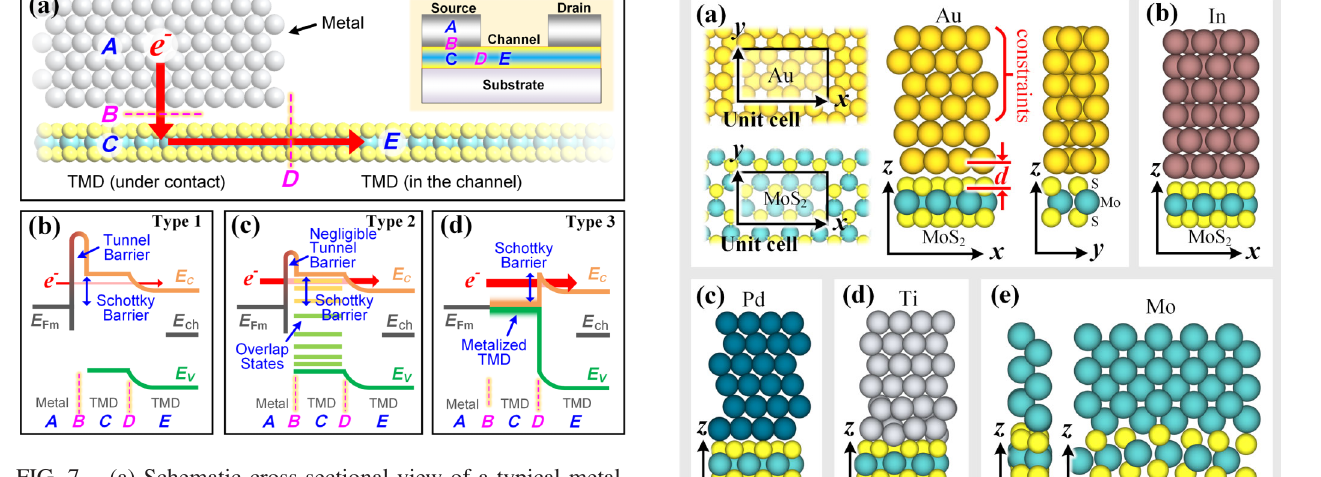
FIG. 7. (a) Schematic cross-sectional view of a typical metal- MoS 2 contact ( n -type top contact). A , C , and E denote the three regions while B and D are the two interfaces separating them. Red arrows show the pathway ( A → B → C → D → E ) of electron injection from contact metal ( A ) to the MoS 2 channel ( E ). The inset shows the source and drain contacts and the channel region in a typical backgated FET. (b) – (d) The three possible band diagrams of (a): metal contacts with (b) very weak bonding, (c) medium bonding, and (d) strong bonding. E E , and E represent conduction band edge, valence band edge, Fm ch metal Fermi level, and channel potential, respectively.